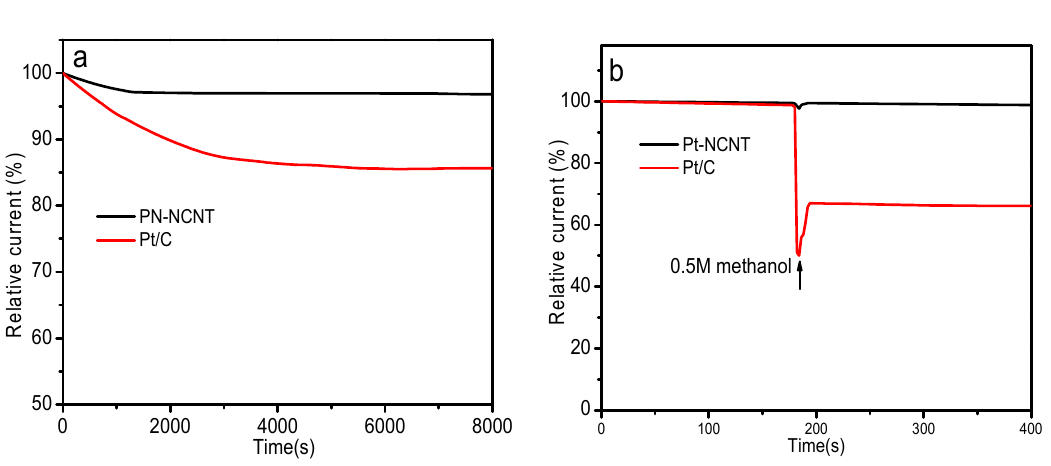
Figure 4. ( a ) Long-term test of PN-NCNT and Pt / C while an oxygen-saturated 0.1 M KOH solution was employed as the electrolyte as well as the rotation speed setting at 1500 rpm. ( b ) Methanol tolerance of PN-NCNT and Pt / C, while an oxygen-saturated 0.1 M KOH solution was employed as the electrolyte as well as the rotation speed setting at 1500 rpm with the injection of 0.5 M methanol during a chronoamperometric measurement.